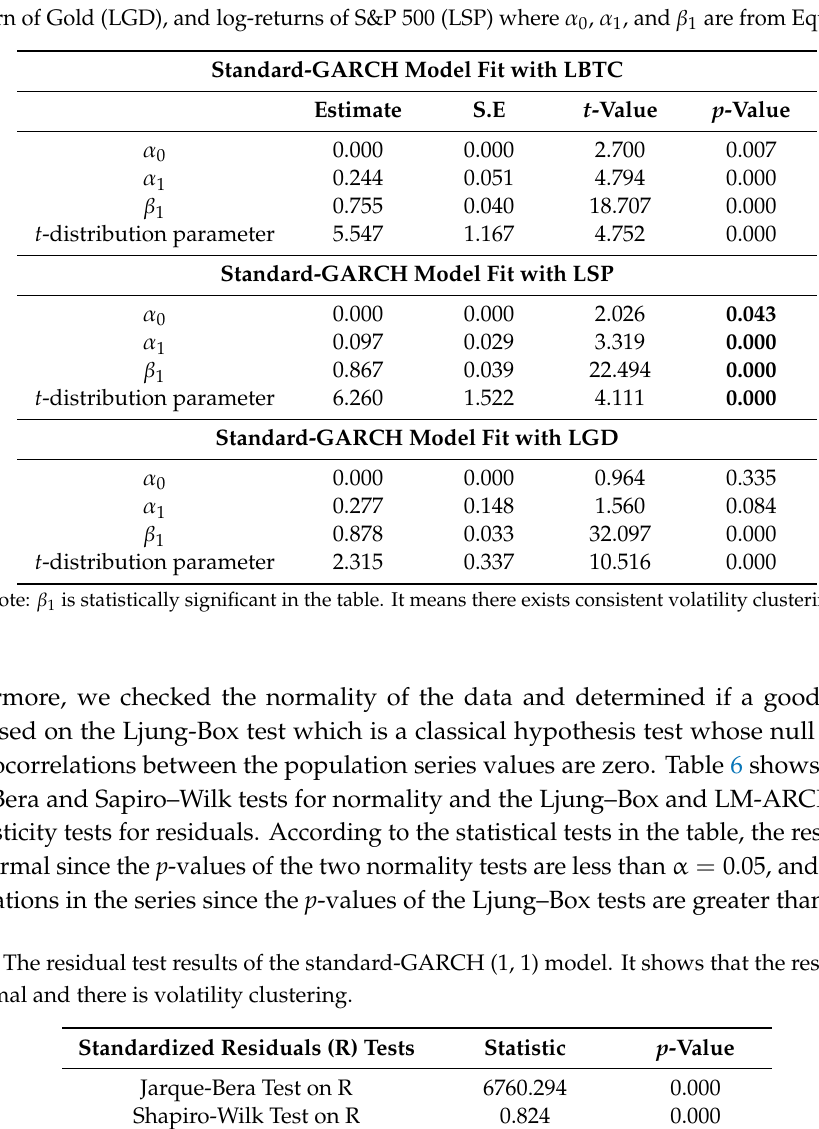
Table 5. The results of the standard-GARCH (1, 1) model with the log-return of Bitcoin (LBTC), log-return of Gold (LGD), and log-returns of S&P 500 (LSP) where α 0 , α 1 , and β 1 are from Equation